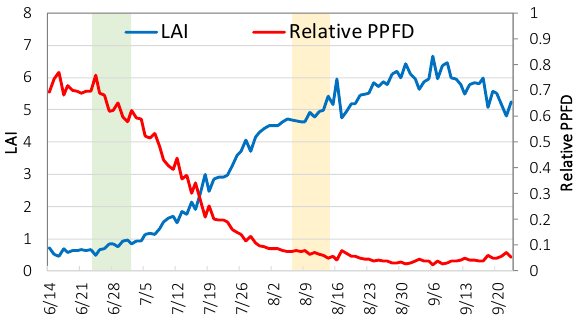
Figure 6. Daily change of relative PPFD and LAI (light green: maximum tiller stage and light orange: heading date) 3.2 Relations of relative PPFD and LAI with CIs, VC and